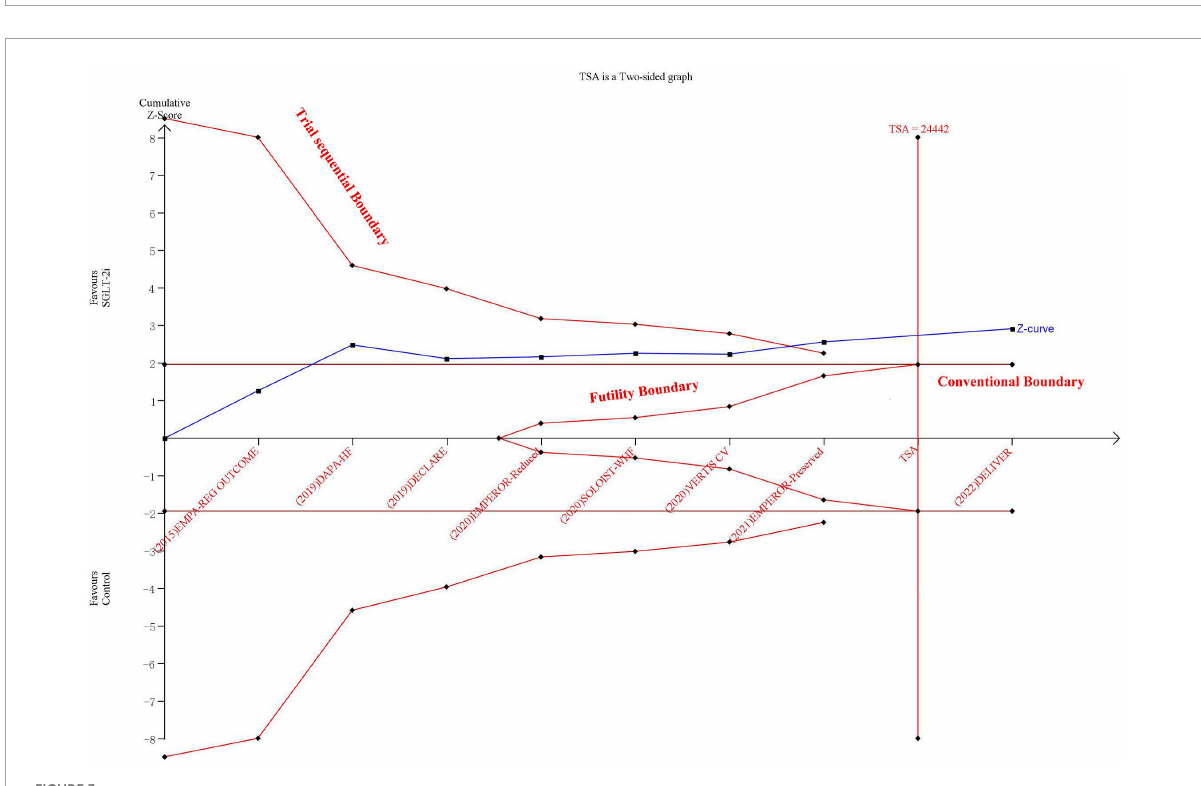
FIGURE3 The trial sequential analysis in terms of cardiovascular